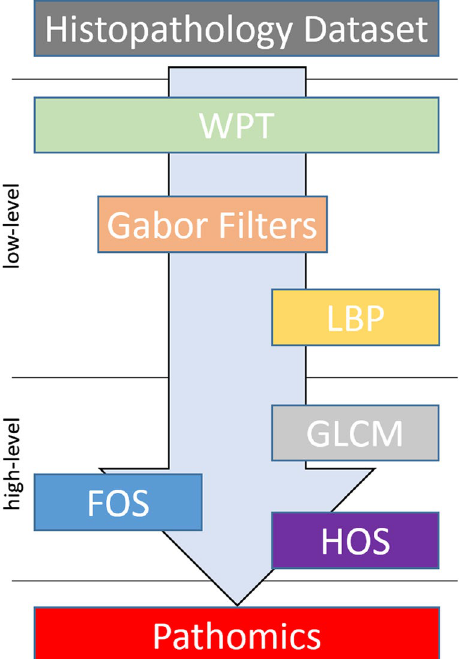
Figure 4. The proposed multi-level feature extraction strategy including several combinations of WPT, Gabor filters, LBP, GLCM, first and high order statistics. WPT wavelet packet transform, LBP local binary patterns, GLCM grey level co-occurrence matrices, FOS first order statistics, HOS higher order statistics. (Figure created in PowerPoint 2013, https:// www. micro soft. com/ micro soft- 365/ power